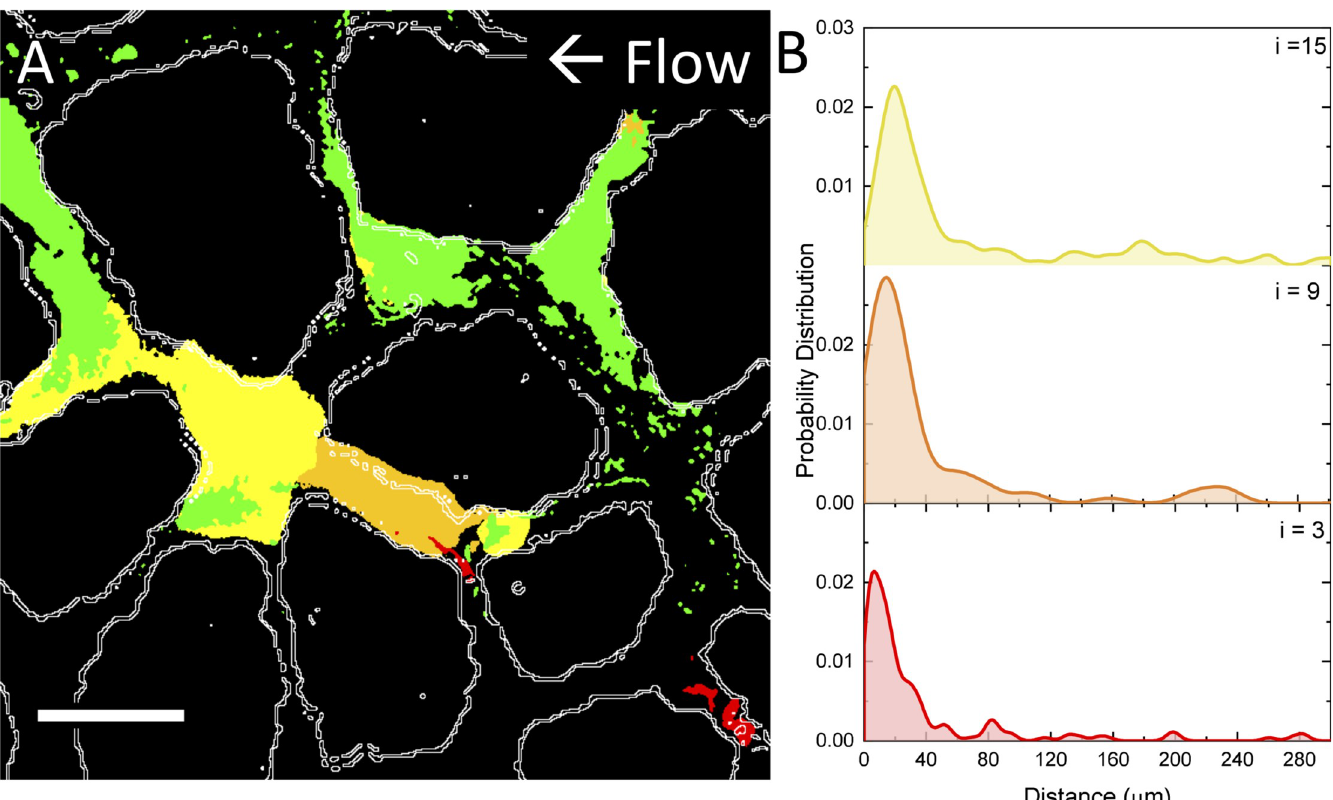
Fig 5. The spatial distribution of biofilms over time depends on the historical location of the mother cell. (A) The change in WT bacterial fluorescence over time from 0–3 hours (red), 3–9 hours (orange), 9–15 hours (yellow), and 15–21 hours (green) show that bacteria biofilms are growing steadily in a downstream direction. The original fluorescent images were thresholded, subtracted, and falsely colored to highlight the changes to the biofilm over time. (B) The nearest neighbour probability for i = 3, 9, and 15 hours shows that nearest neighbors are within a 20 μ m radius (not considering pore space